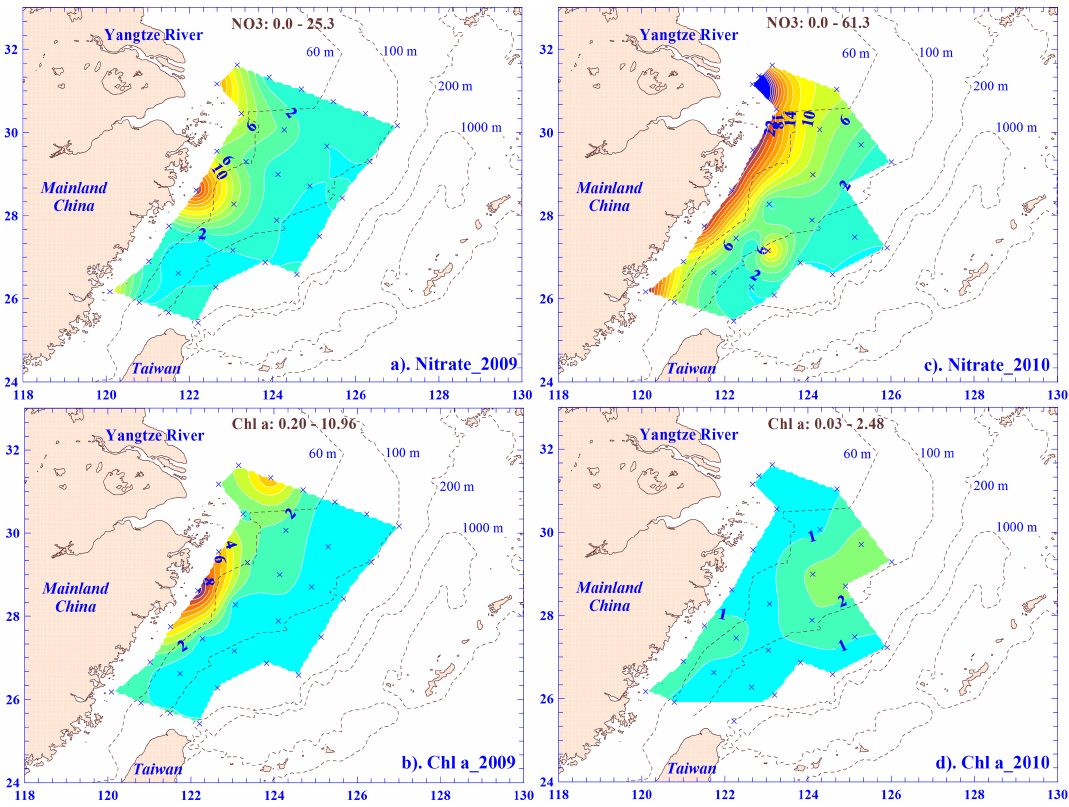
Fig. 3. Contour plots of nitrate and chlorophyll a (Chl a) in the surface waters of the ECS in 2009 (a) , (b) and 2010 (c) , (d) . The contour intervals of nitrate and Chl a are 2µM and 1mg Chlm − 3 ,